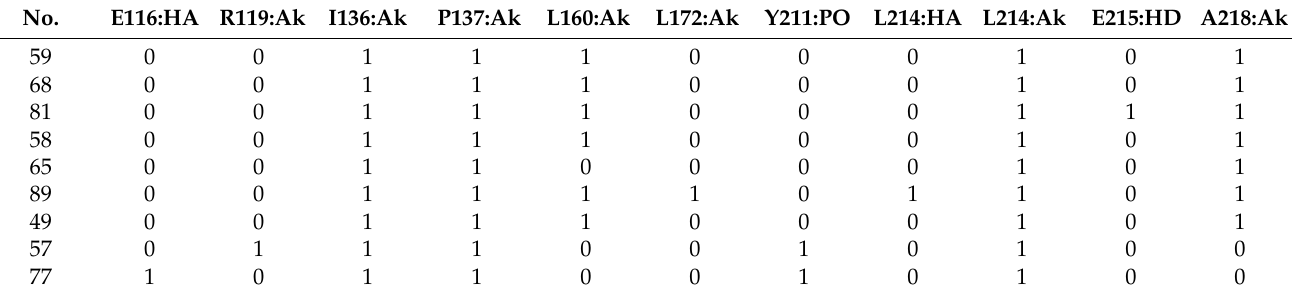
Figure 6. ( A ) LUMO orbit of γ -Maaliene; ( B ) γ -Maaliene group compounds docking with KIF11; ( C ) Active residues around γ -Maaliene binding to KIF11. Table 2. Fingerprint of the γ -maaliene group.